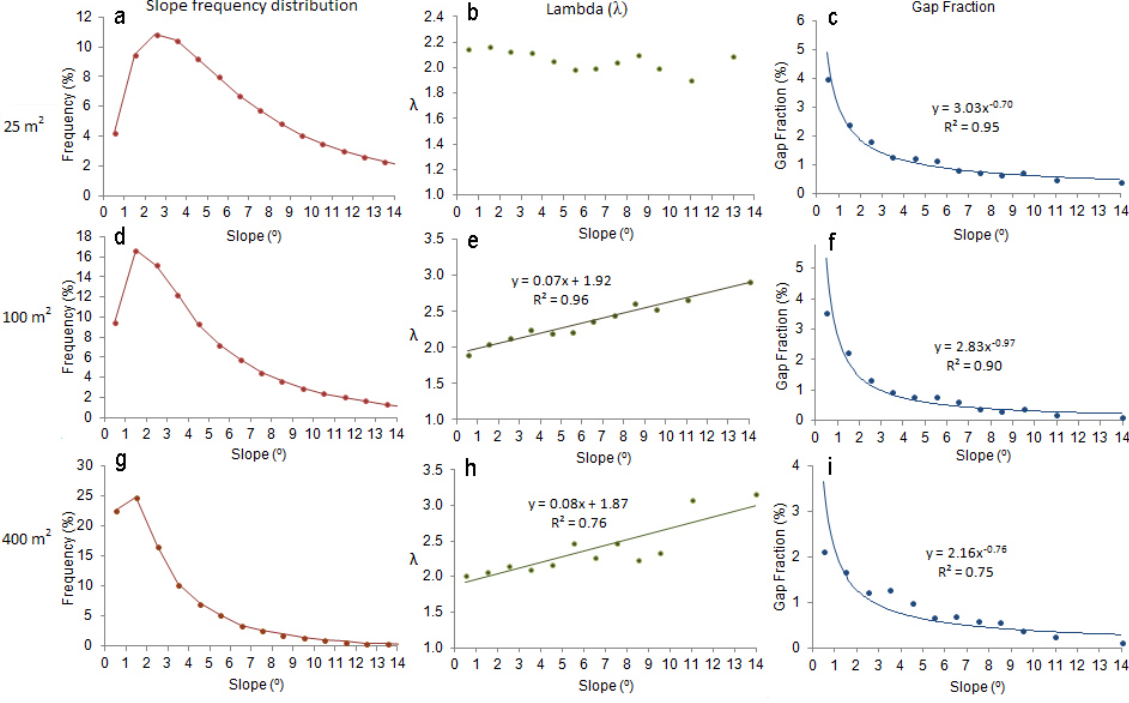
Fig. 4. Frequency distribution of slopes across the landscape ( a , d , g ), gap size-frequency distribution ( b , e , h ) and gap area fraction ( c , f , i ). Fig. 4. Effect of slope on the gap size-frequency distribution (a,d,g) and gap area fraction Slope was evaluated at three different scales: 25, 100, and 400m 2 (b,e,h) . The frequency distribution of slopes across the landscape was also calculated (c,f,i) . 610 Slope was evaluated at three different scales: 25, 100, and 400 m 2 .